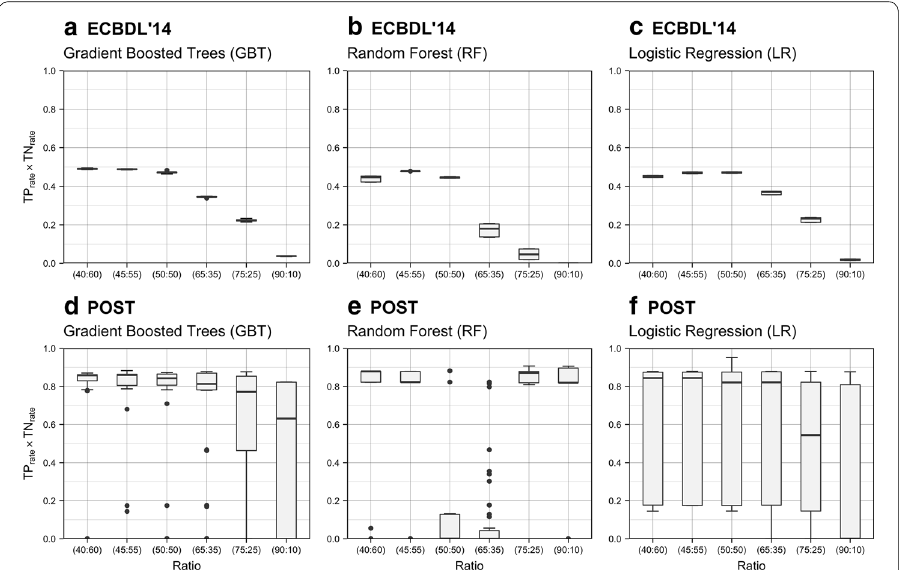
Fig. 3 (Performance scores per class ratio): This figure, which is based on tabulated results from ANOVA and Tukey’s HSD tests, shows the top three class ratio distributions for both original datasets. Box plots are used to visualize the median (middle quartile or the 50th percentile shown as a thick line), two hinges (25th and 75th percentiles), two whiskers (also known as error bars), and outlying points. The top three class distributions for the ECBDL’14 dataset with regards to performance were consistent for all three learners. These distributions are the 40:60, 45:55, and 50:50 ratios, as shown in a – c . From a performance perspective, there was less consistency for the top three distributions of the POST dataset, as shown in d –